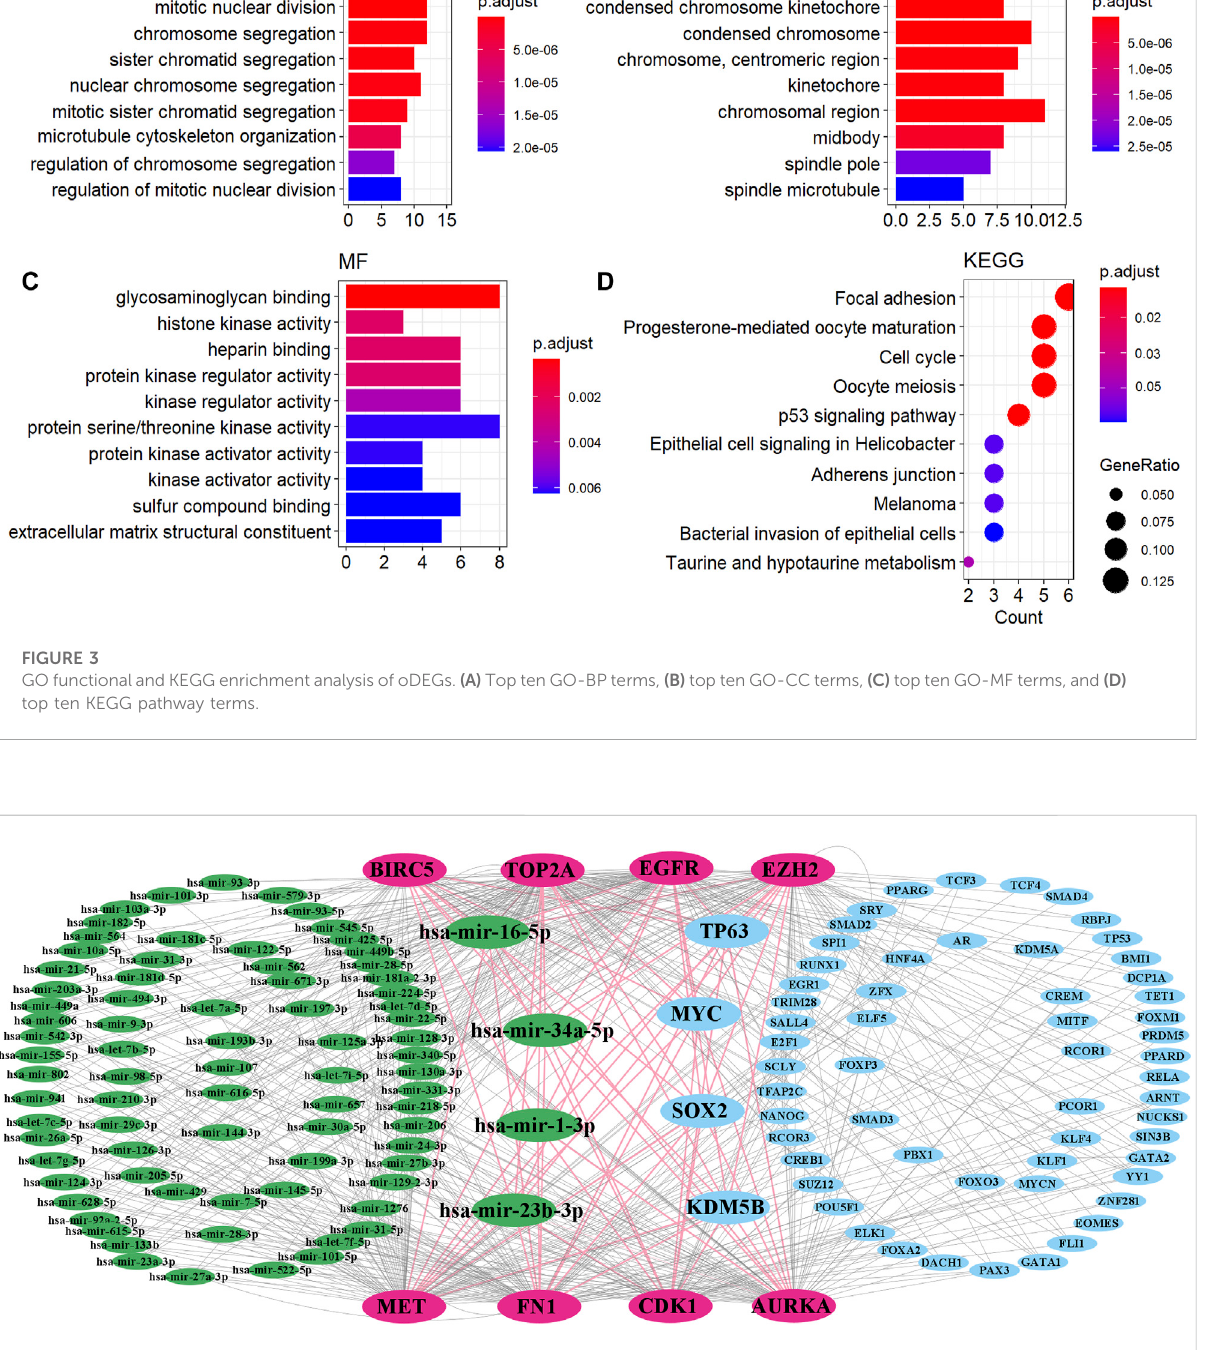
FIGURE 4 TF-KG – miRNAinteractionnetwork,wherepinkindicatesKGs,greenindicatesmiRNAs,blueindicatesTFs,andlargegreenandblueindicatekey miRNAs and TFs,